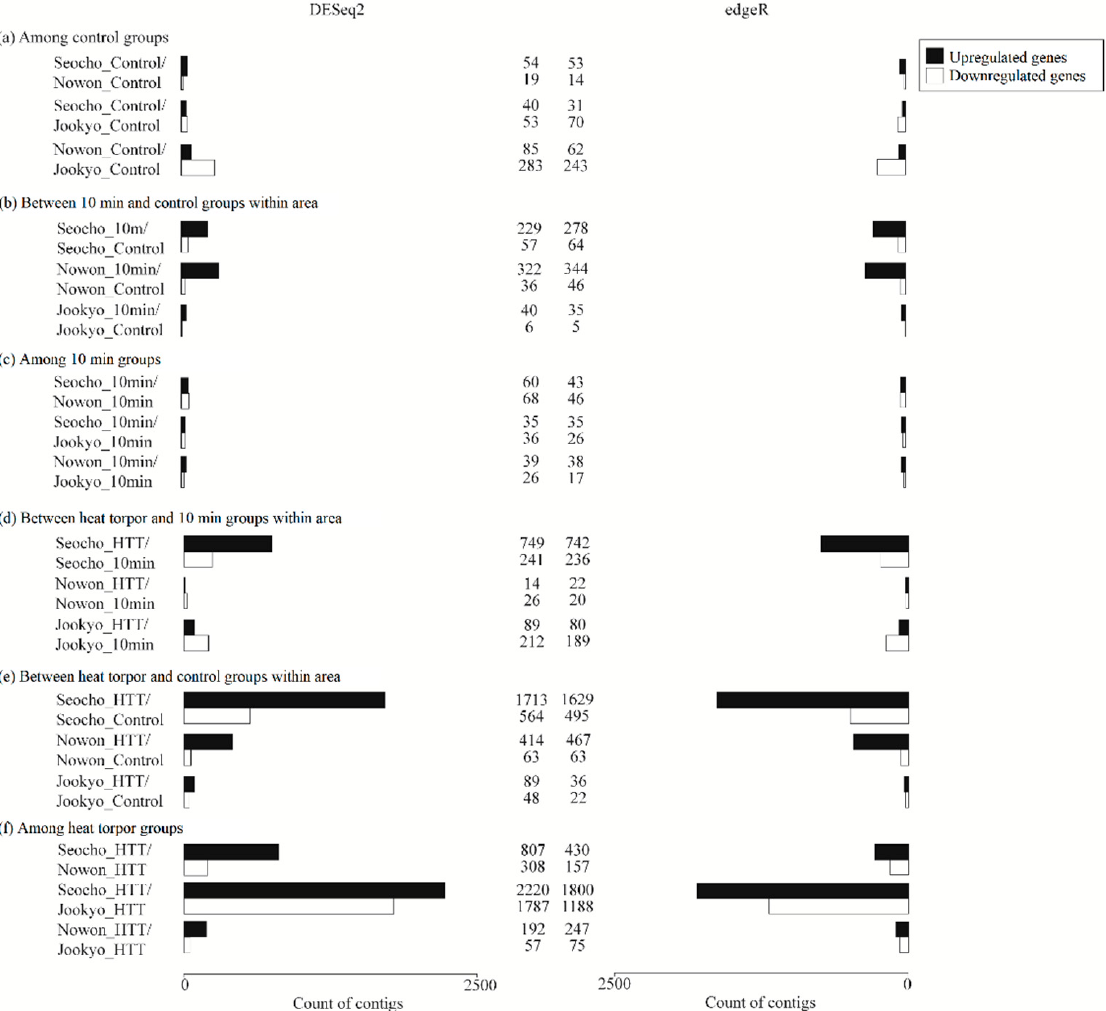
Figure 3. Bar charts presenting the number of significantly differently expressed genes (DEGs) from pairwise comparisons identified using DESeq2 and edgeR analysis platforms. Significantly differently expressed genes satisfied |fc| > 2 and adjusted p -values < 0.05. Black bars denote upregulated genes and white bars denote downregulated genes. Seocho, Nowon, and Jookyo represent high-UHI, low-UHI, and surrounding areas, respectively. ( a – f ): Pairwise comparisons of number of DEGs of H. fuscata cicadas among control groups, between 10 min and control group within area, among 10 min groups, between heat torpor and 10 min groups within area, between heat torpor and control groups within area, and among heat torpor groups, respectively.